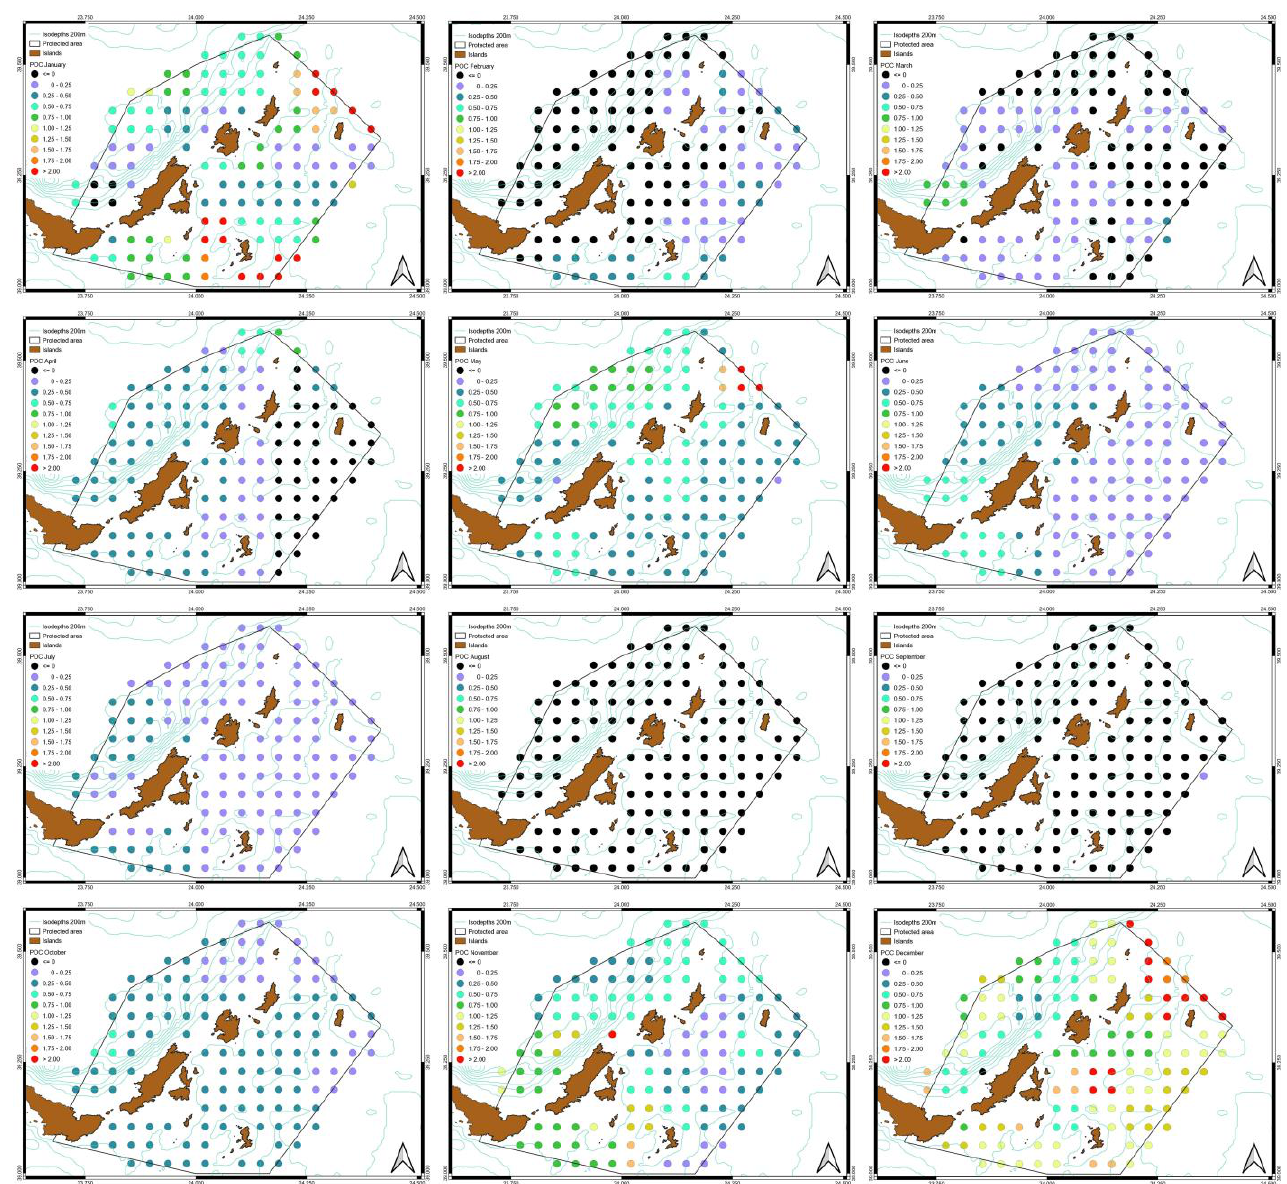
Figure 11. Monthly spatial variation of POC slopes. The availability of POC increases for most of the year with a characteristic decrease during August and September.